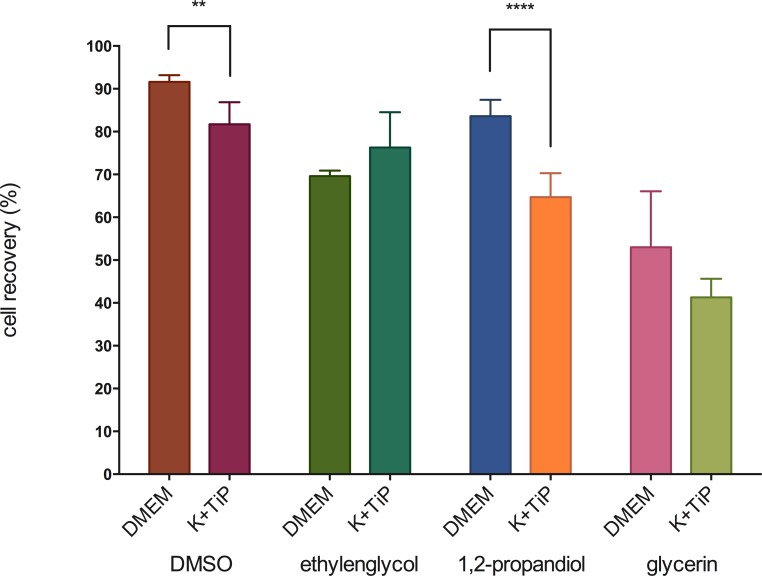
Cell recovery by using slow freezing methods.Figure 1 illustrates cell recovery of slowly frozen MHEC-5Ts immediately after thawing. DMEM = DMEM Ham’s F-12 Gln+, 20% FBS, and 1.5M of one of the CPAs; K+TiP = K+TiP. 0.5M sucrose, 20% FBS, and 1.5M of one of the CPAs; ** = medium significant (p < 0.01); **** = highest siginificance (p < 0.0001).